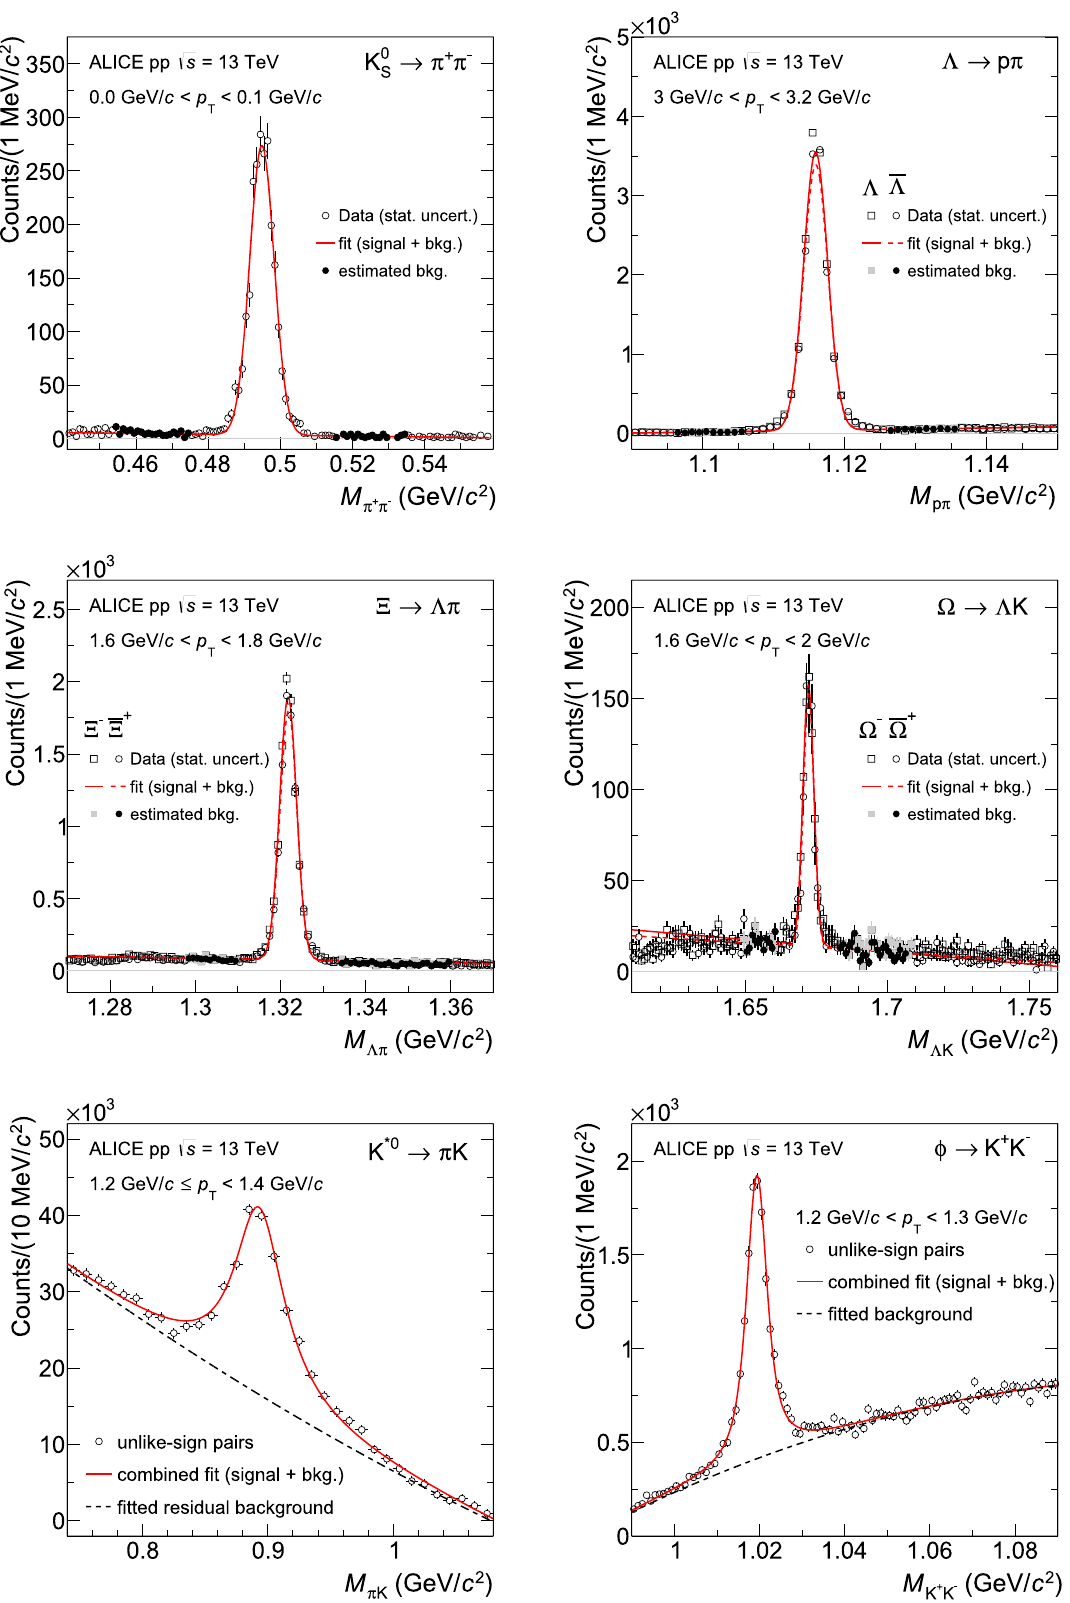
∗ 0 + , K ∗ 0 and K and φ . See the text for